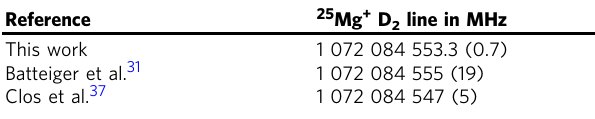
Table 1 Comparison of the 25 Mg + D 2 line transition